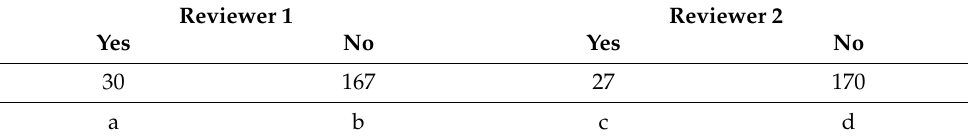
Table A2. Kappa statistics